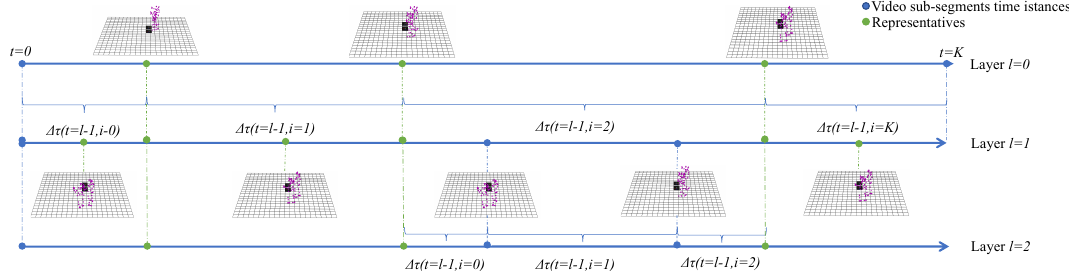
Figure 5. The architecture of the H-SMRS algorithm